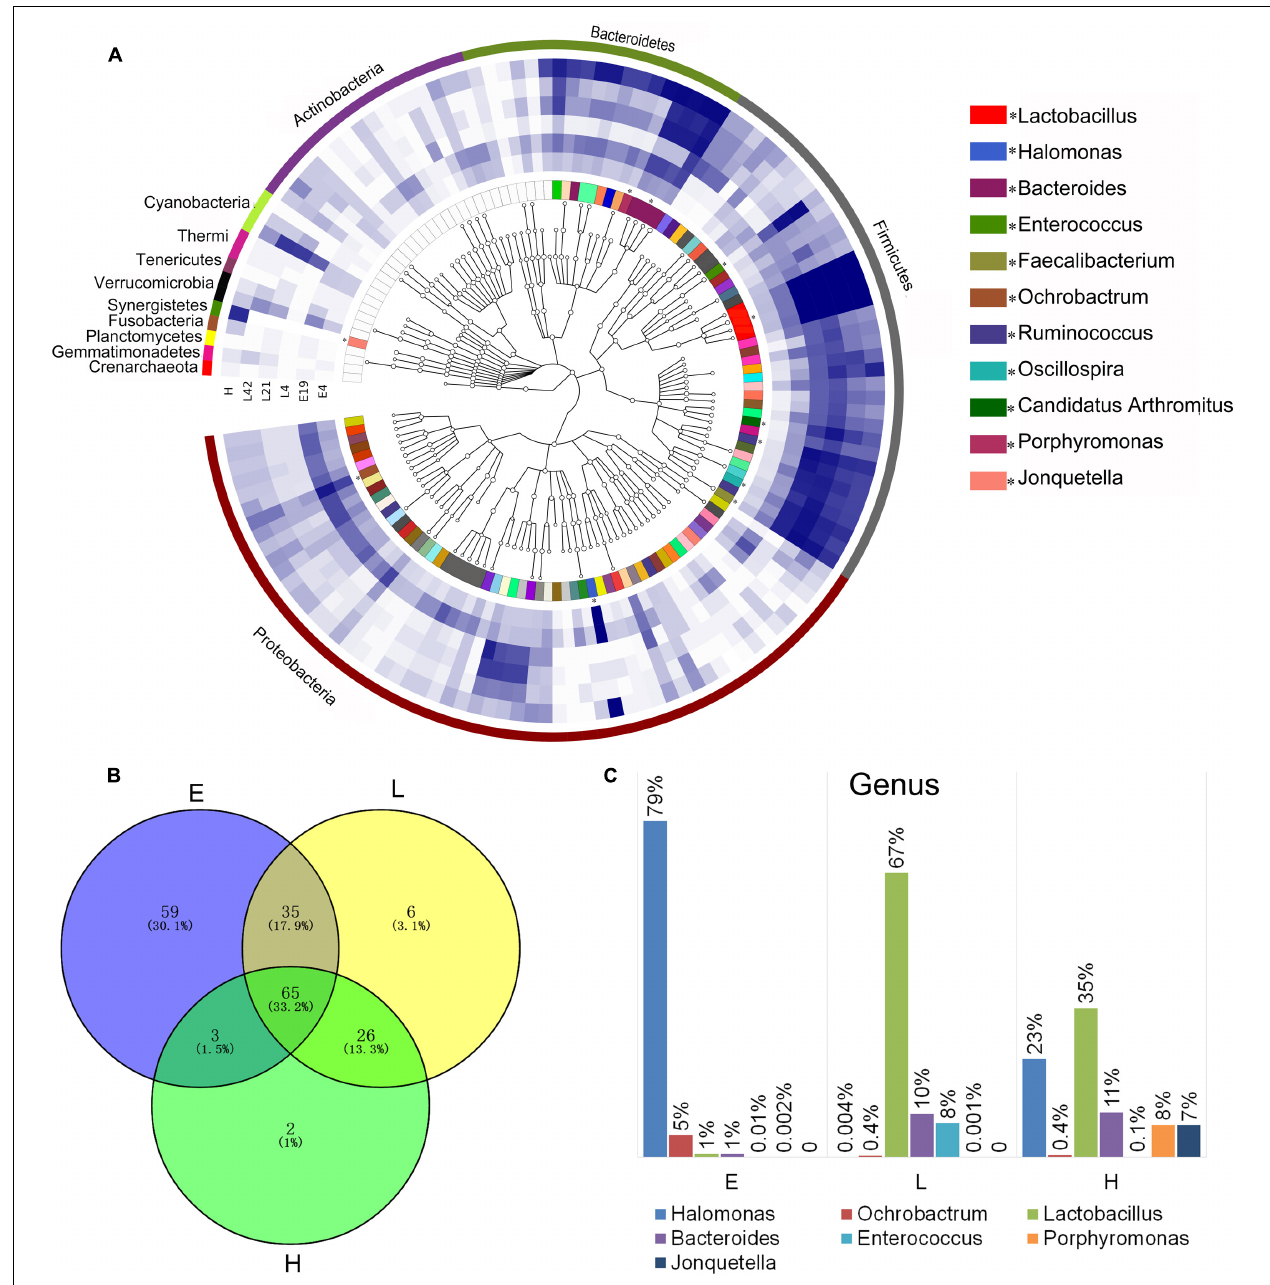
FIGURE 2 | Phylogenetic tree of the taxa and differences in the microbial communities of different development stages. (A) Phylogenetic tree constructed from the 188 taxa. Colored blocks in the outermost circle indicate phyla, and in the inner circle indicate genera. The heatmap circles show relative abundance of embryos (E) E4 and E19; chicks (L) at 4 (L4), 21 (L21), and 42 days (L42) post hatch; and maternal hens (H). (B) The Venn diagram shows the microbes shared within different host development stages (see Supplementary Table S3 in the Supplementary Material). (C) Microbial composition structure of embryos, chicks, and maternal hens at the genus